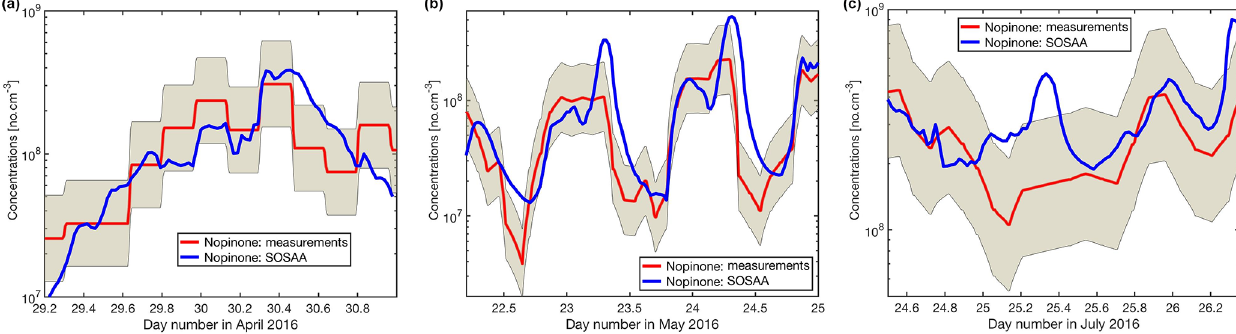
Figure C1. Mixing ratio of measured (red line and shaded area for 50% uncertainty) and modelled (blue line) nopinone for the three modelled periods in April, May, and July (a–c)